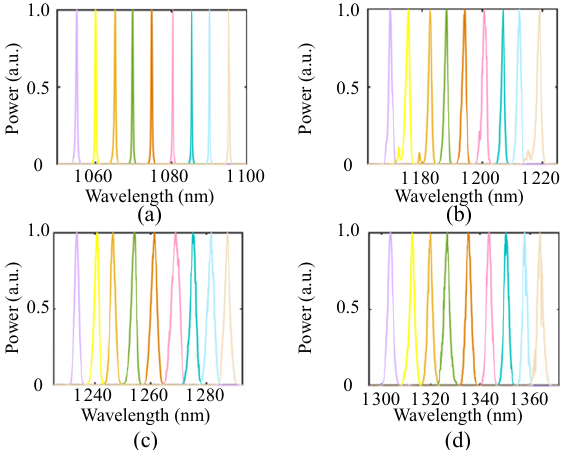
Fig. 7 Normalized spectra of the tunable: (a) YRFL pump, (b) 2nd-, (c) 3rd- and (d) 4th-order random